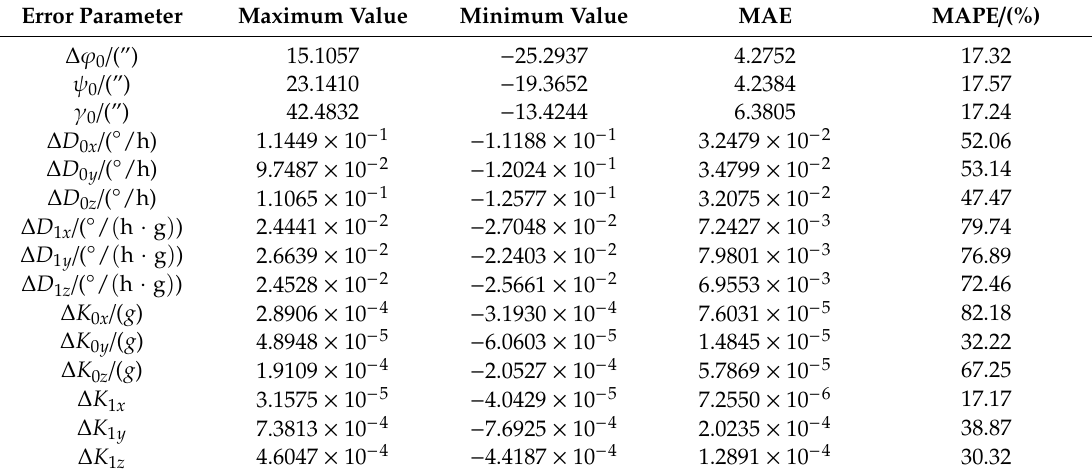
Figure 12. Contrast results of accelerometer residual error using RBM-BPNN and IRBM-BPNN method. Table 3. Statistical results of error parameter forecast values using IRBM-BPNN method. Error